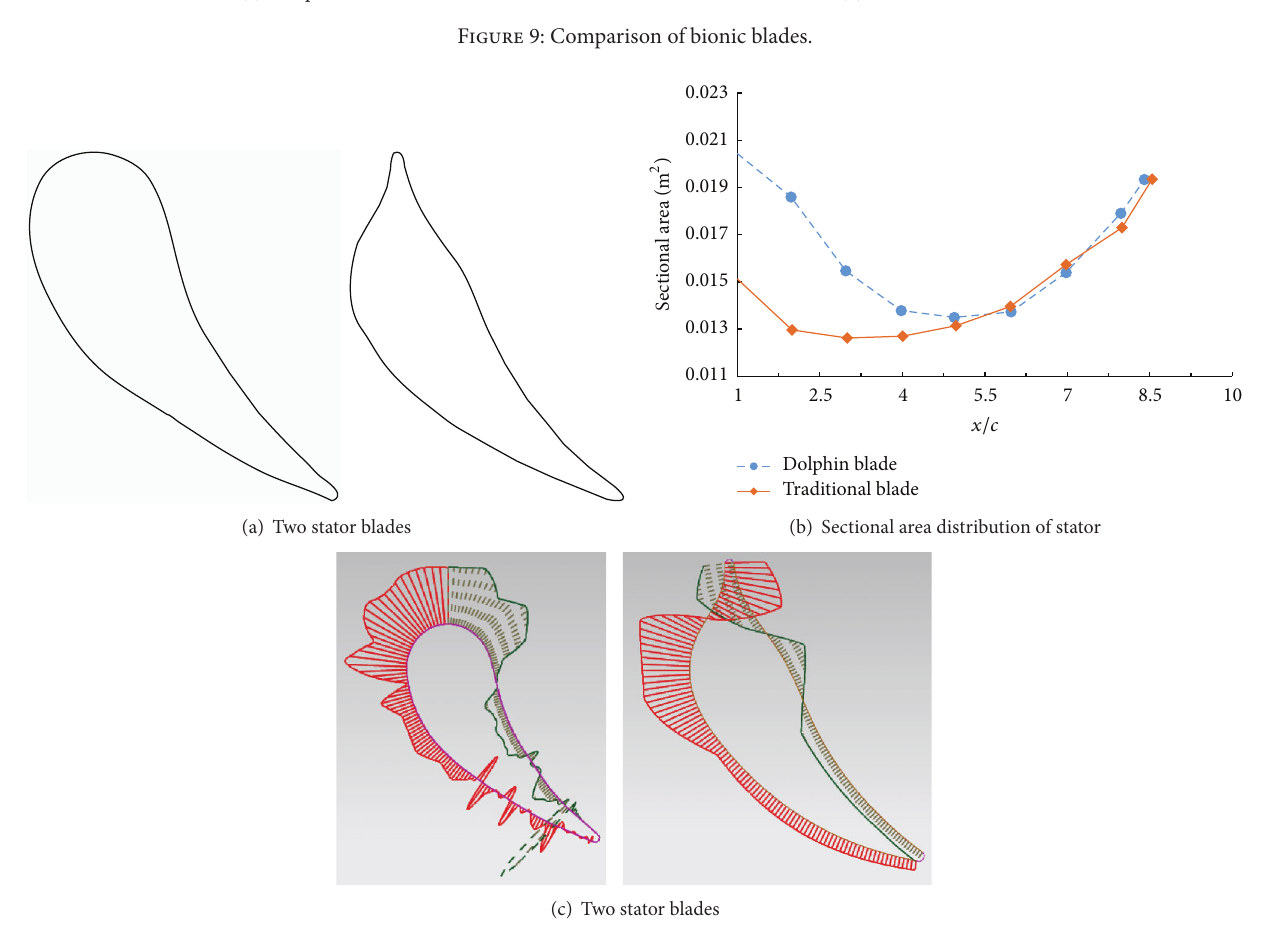
Figure 10: Comparison of traditional and bionic